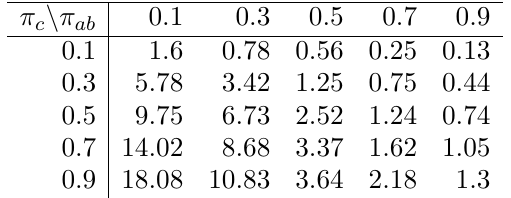
Table 2. Comparison of standard deviation of out-of-sample perfor-